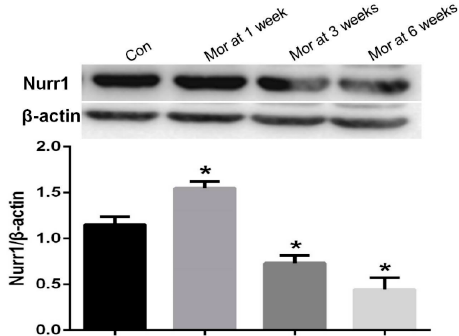
Figure 5. Western blot analysis of Nurr1 expression in the VTA. The relative level of Nurr1 in the VTA after one week of morphine exposure increased compared with the control group ( P < 0.05). However, with prolonged morphine exposure, the relative Nurr1 expression of the three week and six week morphine-dependent groups decreased markedly ( P < 0.05). Data are presented as the mean ± SEM. * P < 0.05 vs. control group ( n = 4).